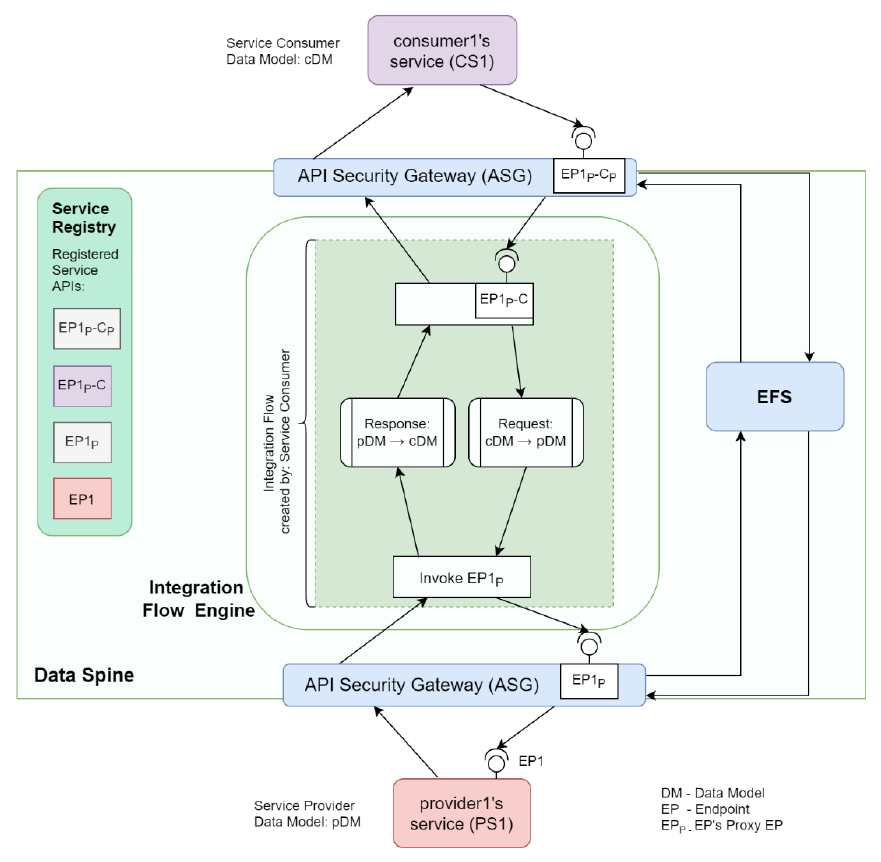
Figure 10. Example of synchronous communication workflow through the Data Spine.